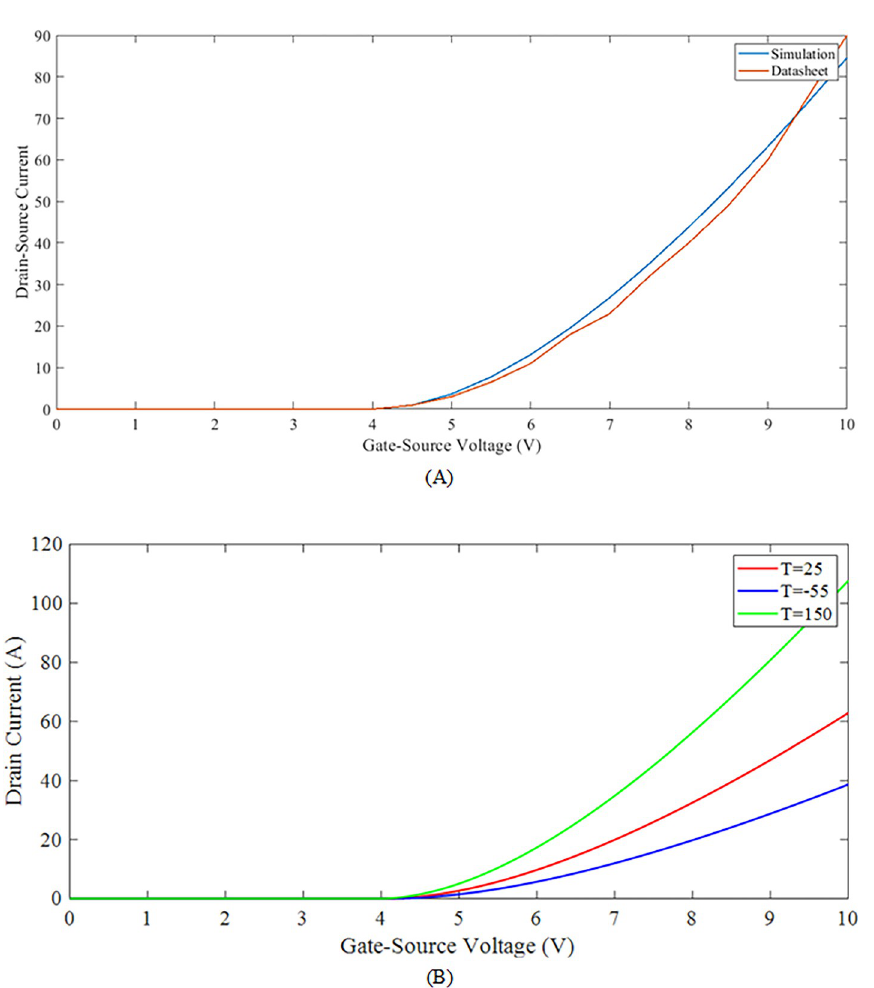
Fig 8. Comparison of proposed SiC MOSFET model input transfer characteristics (A) impact of temperature (B) comparison to datasheet at T = 25˚ C